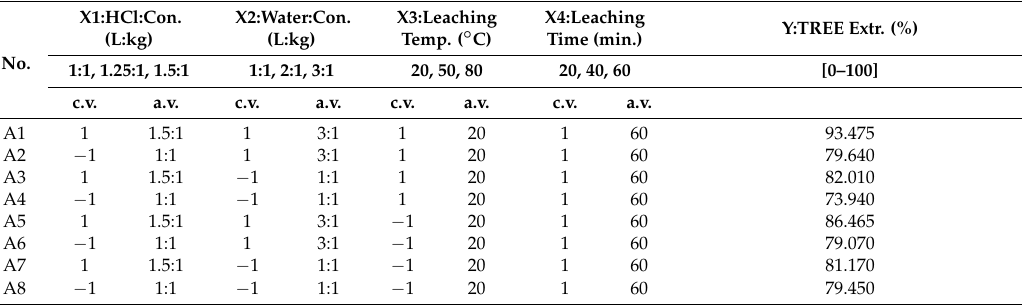
Table 2. Experiment design